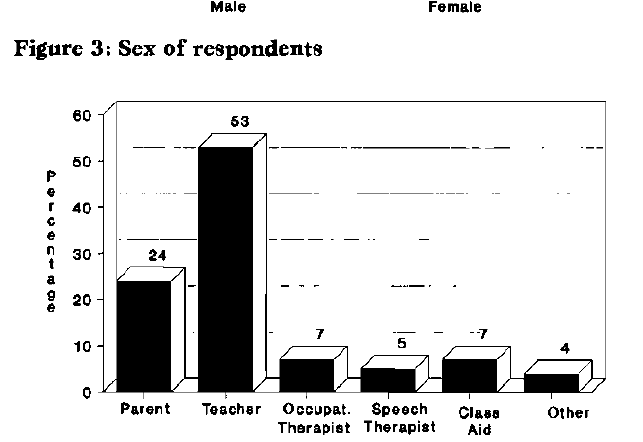
Figure 3: Sex of respondents